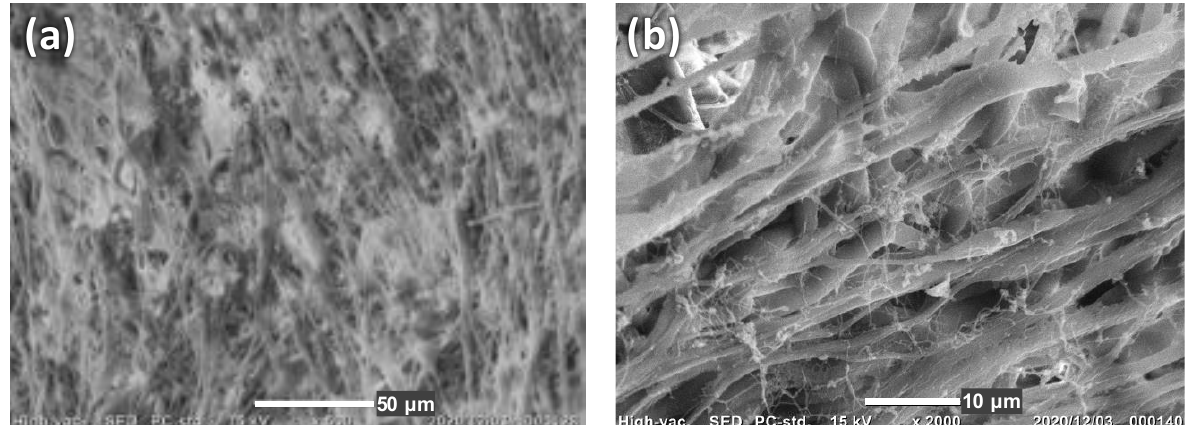
Figure 7. ( a ) High-density extracellular matrix ( b ) secreted web of collagen fibrils from U251 MG cells in a nanofiber-mâché ball.